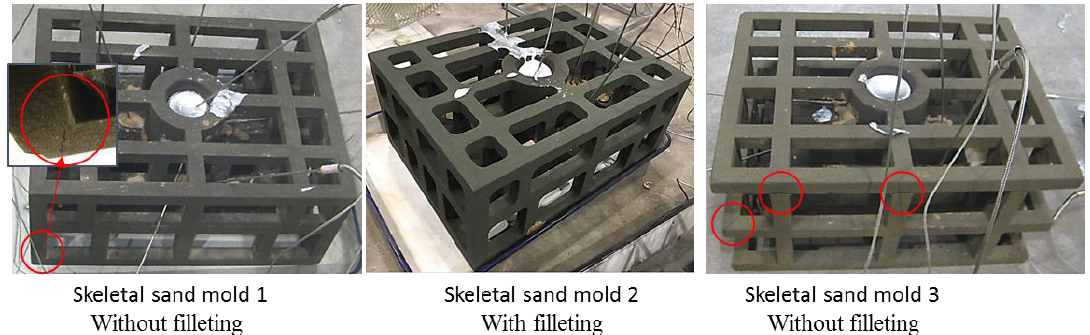
Figure 33. Comparison of cracks in the skeletal sand molds with and without filleting.